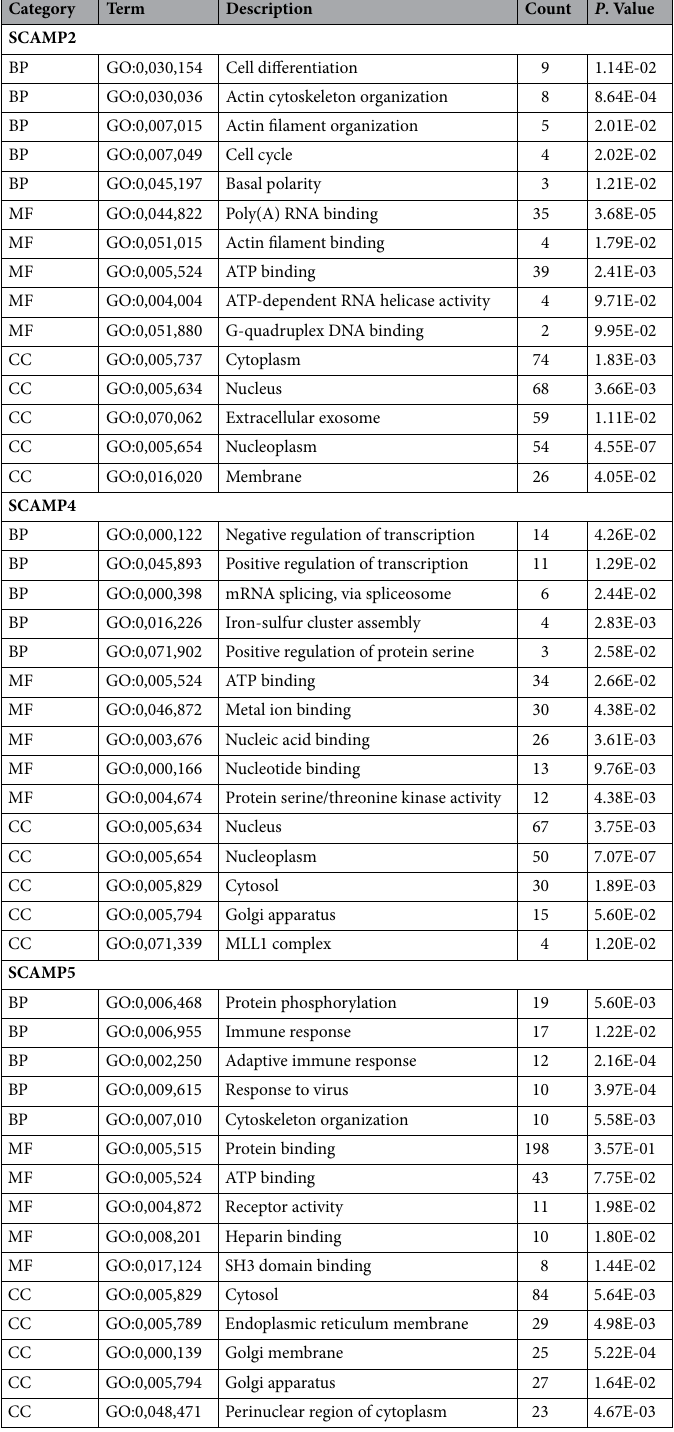
Table 3. The top 5 GO function enrichment analysis of SCAMPs and co-expressed genes in AML